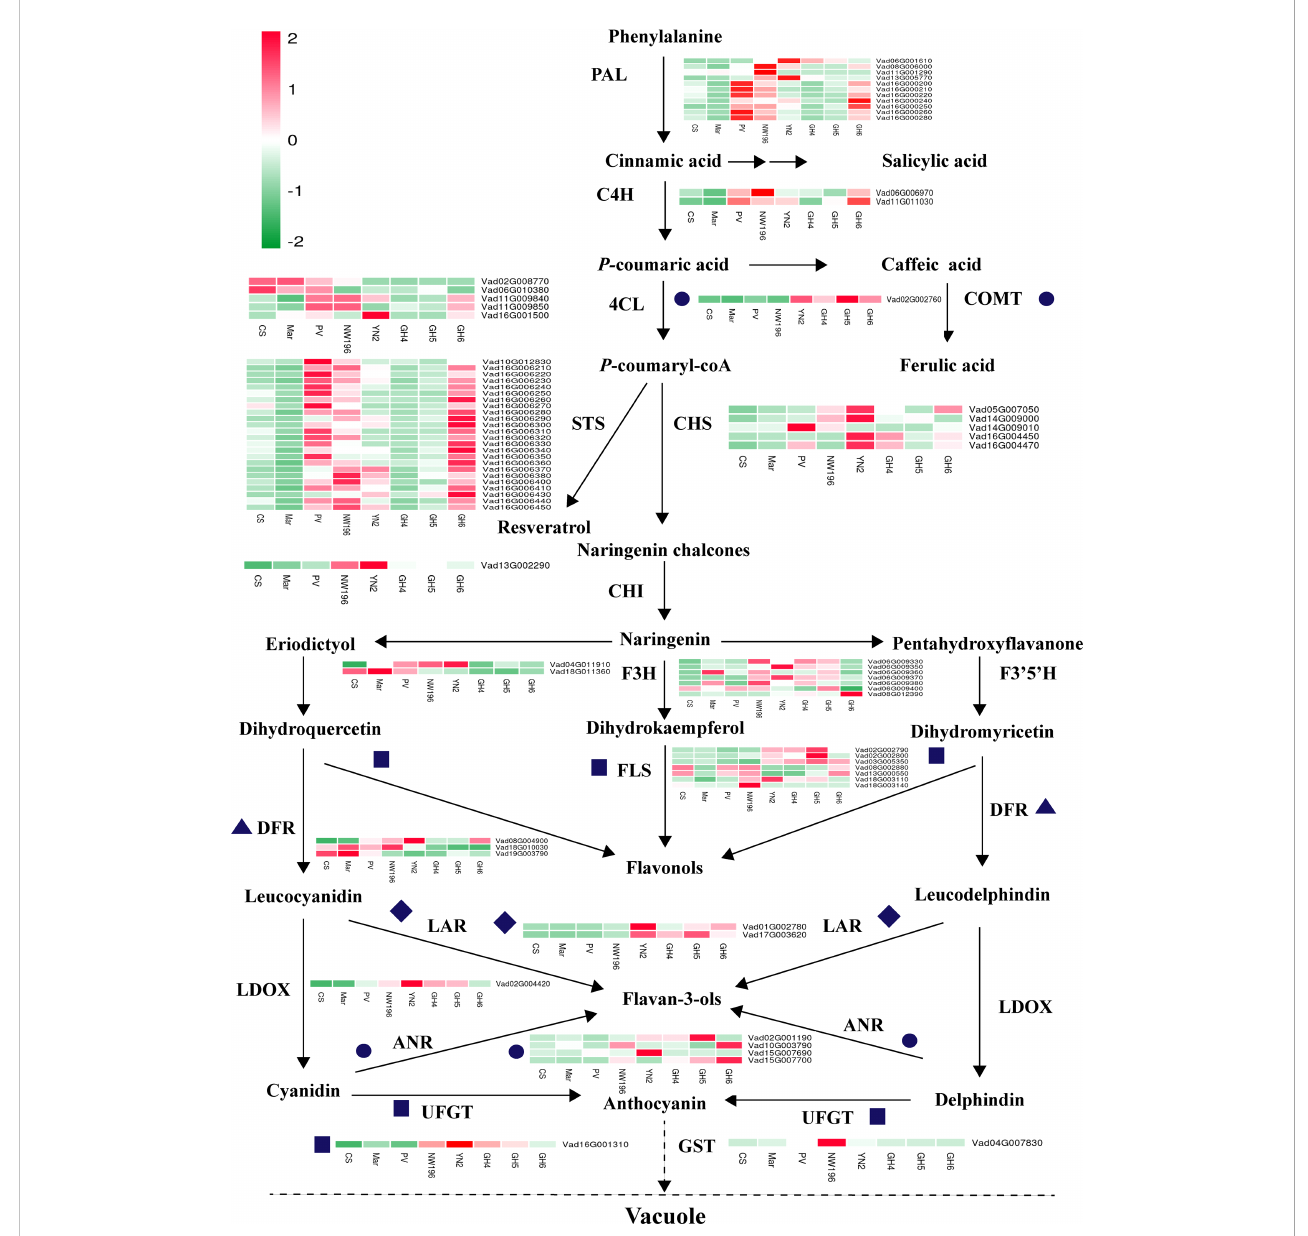
FIGURE 6 Transcriptomic analysis of structural DEGs implicated in phenolic biosynthesis within berries of eight grape varieties. 4CL, 4-coumarate: CoA ligase; ANR, anthocyanidin reductase; C4H, trans -cinnamate 4-monooxygenase; CHS, chalcone synthase; CHI, chalcone isomerase; COMT, caffeic acid 3- O - methyltransferase; DFR, dihydro fl avonol reductase; F3H, fl avonoid 3-hydroxylase; F3 ’ 5 ’ H, fl avonoid 3 ’ ,5 ’ -hydroxylase; FLS, fl avonol synthase; GST, glutathione S-transferase; LAR, leucoanthocyanidin reductase; LDOX, leucoanthocyanidin dioxygenase; UFGT, UDP-glucose: fl avonoid 3- O - glucosyltransferase; PAL, phenylalanine ammonia-lyase; STS, stilbene synthase. As highlighted in the legend, each square in the heatmap next to its gene names corresponds to the mean FPKM value of the gene in each